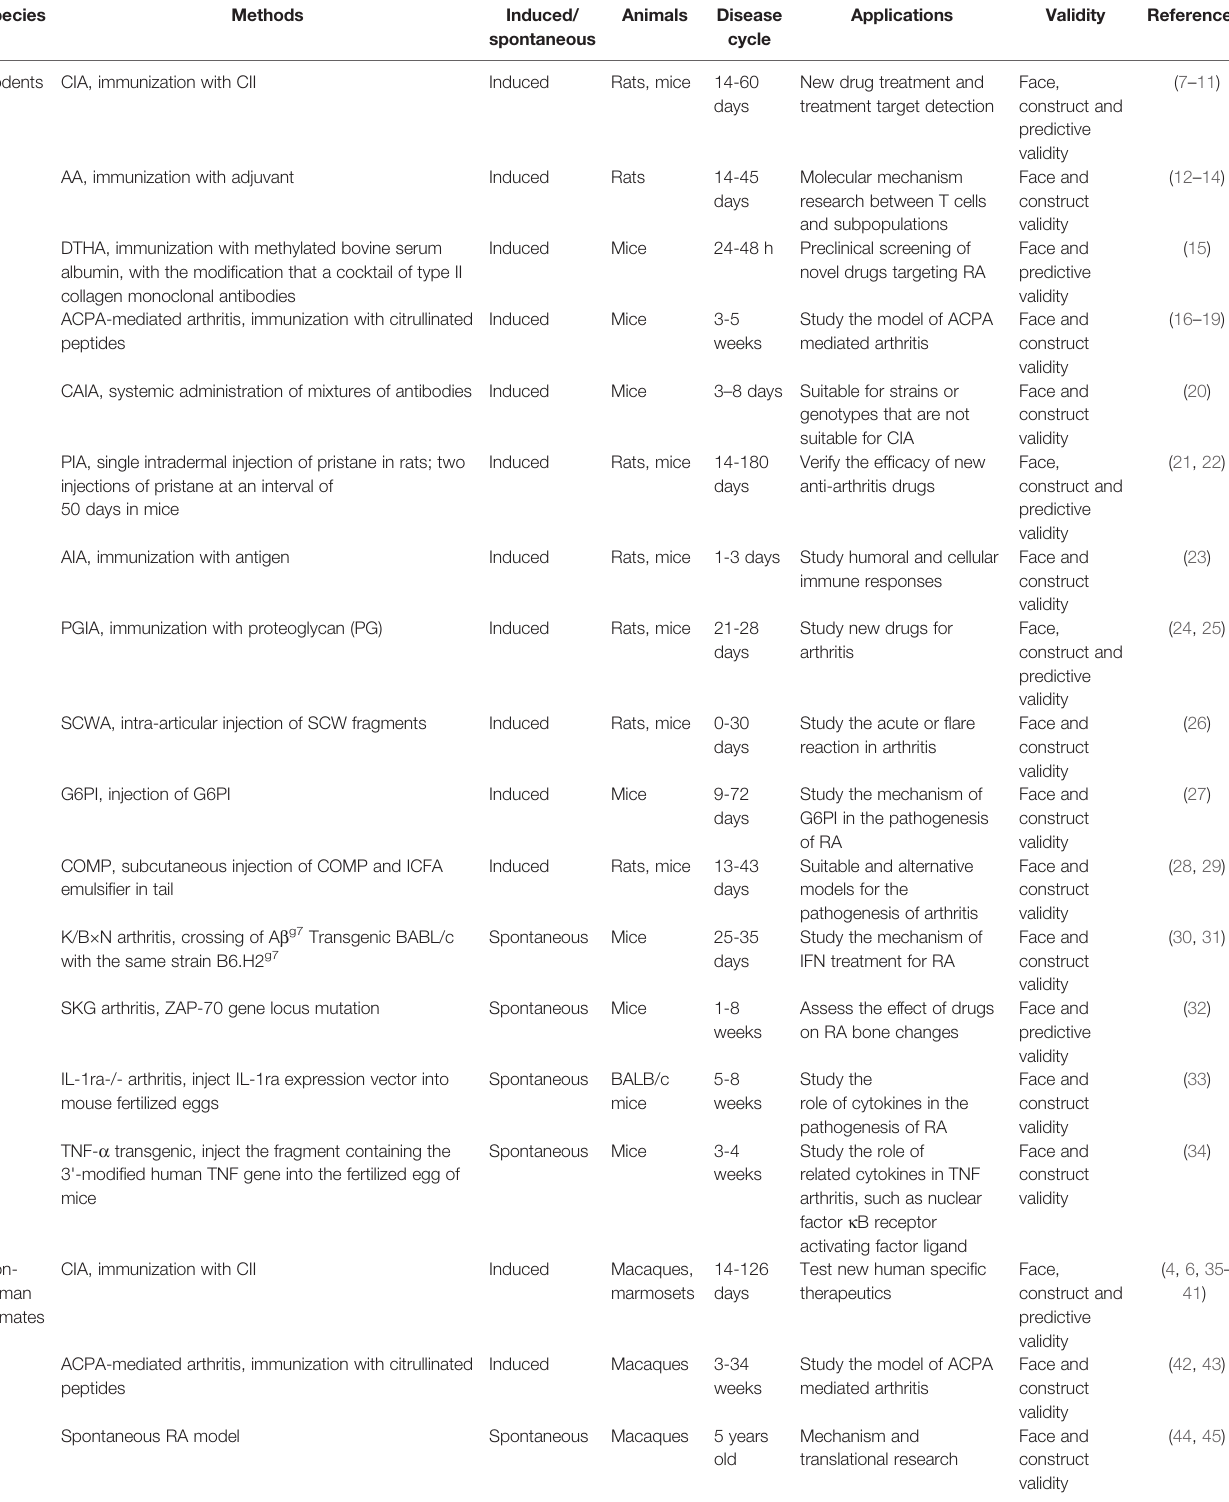
TABLE 1 | Animal models of